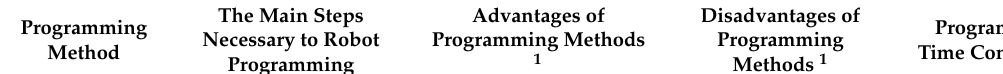
Table 2. Comparison of programming